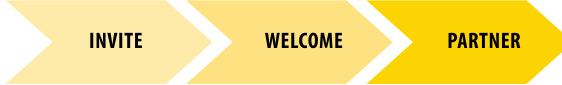
Fig. 3. The tabula plena approach protects what is valued first, enhances what may be underperforming, and then adds new elements informed by effective community